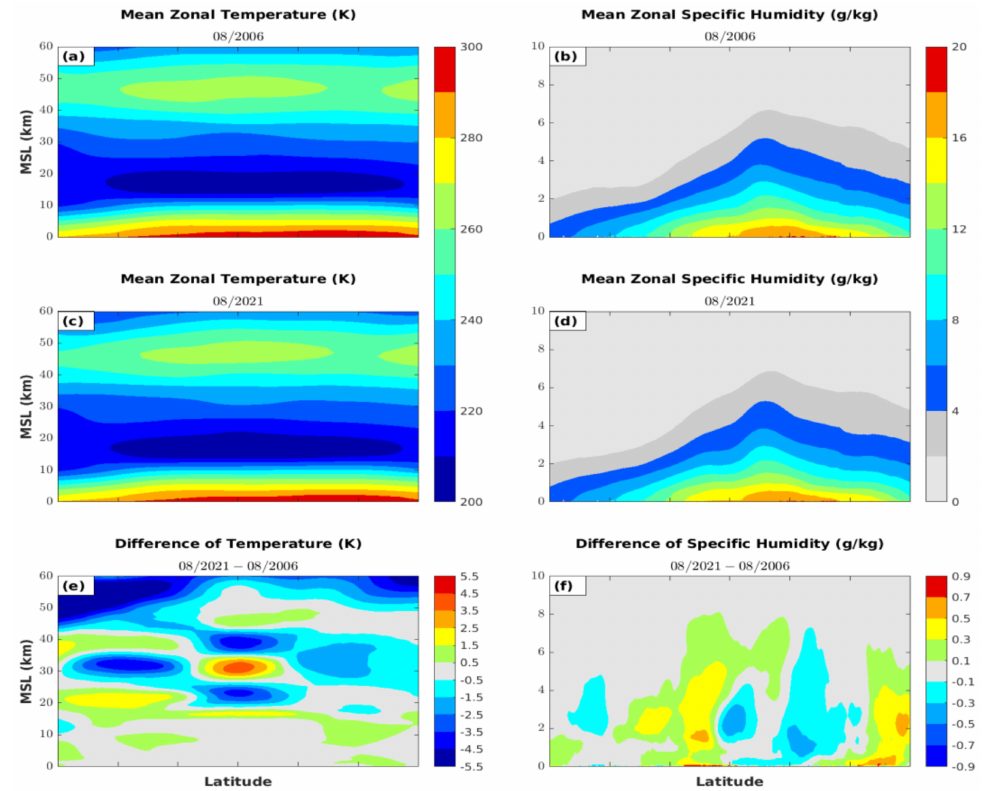
Figure 1. Vertical cross sections of ( a , c ) mean zonal temperature from 0–60 km MSL and ( b , d ) mean specific humidity from 0–10 km MSL for August 2006 and 2021. Differences are shown in ( e ) and ( f ) (August 2021 minus August 2006). Computed from the full ERA5 data